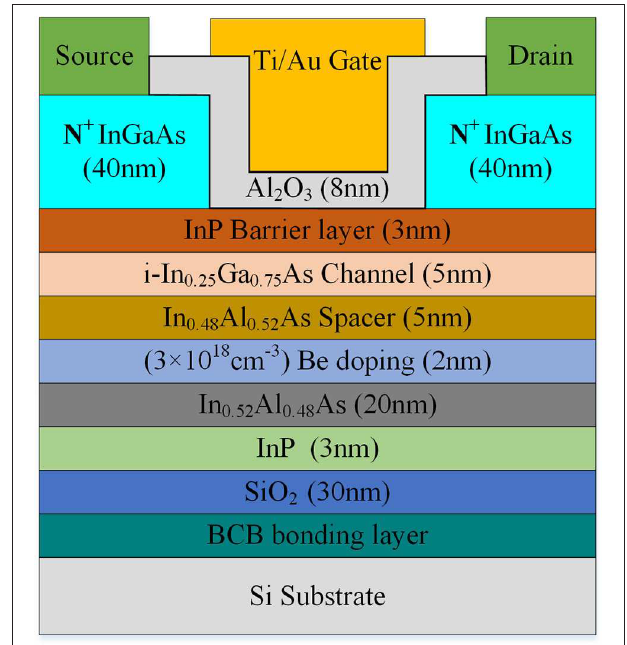
FIGURE 1 | Main structure of buried In 0.25 Ga 0.75 As channel n-MOSFETs with 3nm InP barrier layer and 8nm Al 2 O 3 gate